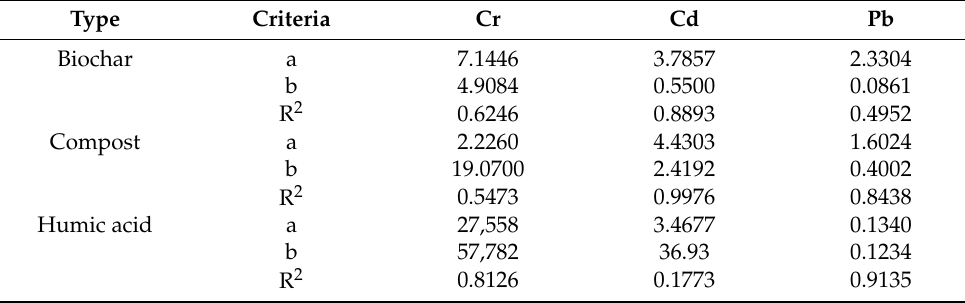
Table 3. The result of the isotherm Freundlich